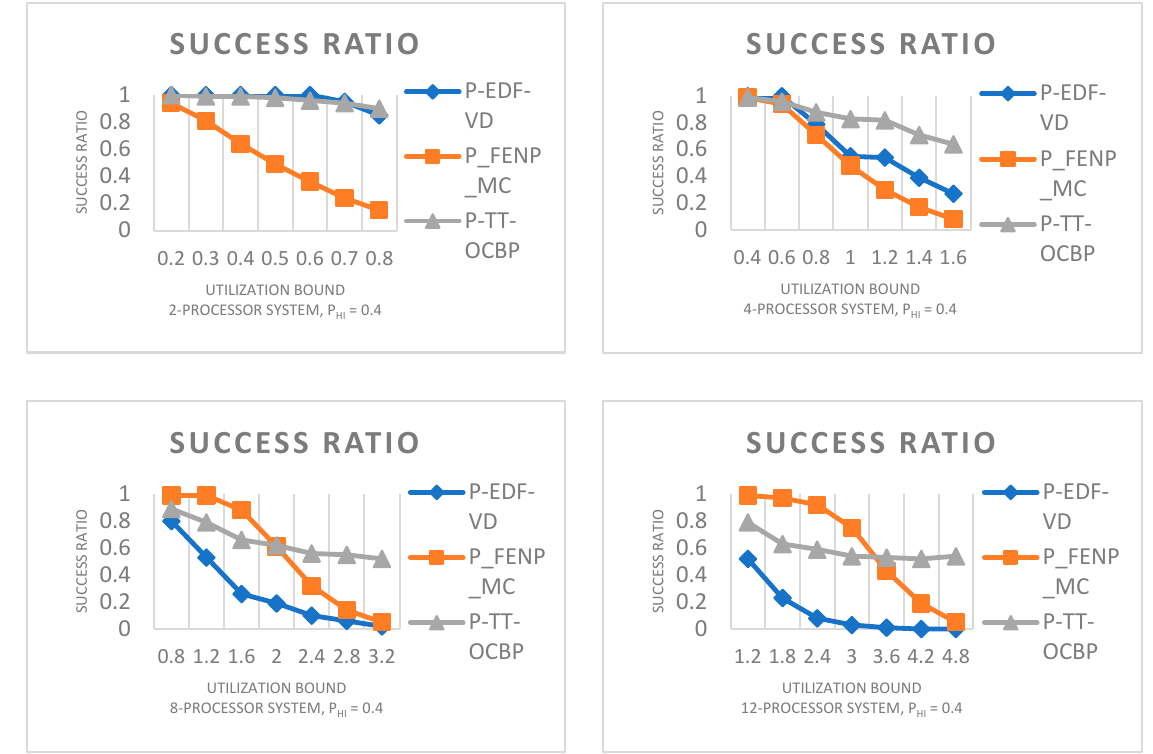
Figure 3. Success ratio by varying the utilization bound. U L = 0.05, U U = 0.75, Z L = 1, Z U = 4. For Figure 4, the number of processors on the x-axis ranges from 2 to 12, in steps of 2. It must be noted that between the four graphs, the Base Utilization bound (𝑈 × (𝑛𝑢𝑚𝑏𝑒𝑟 𝑜𝑓 𝑝𝑟𝑜𝑐𝑒𝑠𝑠𝑜𝑟𝑠/2)), ranges from 0.2 to 0.8, in steps of 0.2. The num- 𝐵𝑈 (cid:3029)(cid:3042)(cid:3048)(cid:3041)(cid:3031) ber of tasks in a task set varies according to the task set utilization bound. Therefore, a lower value on the x-axis decreases the number of tasks in a task set, while a higher value increases it.